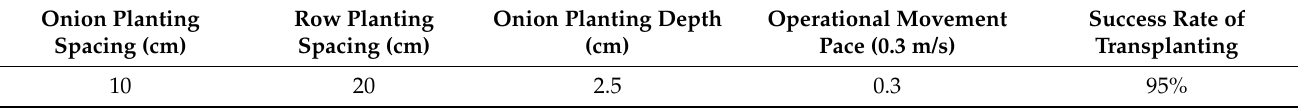
Table 1. Target specifications of the onion